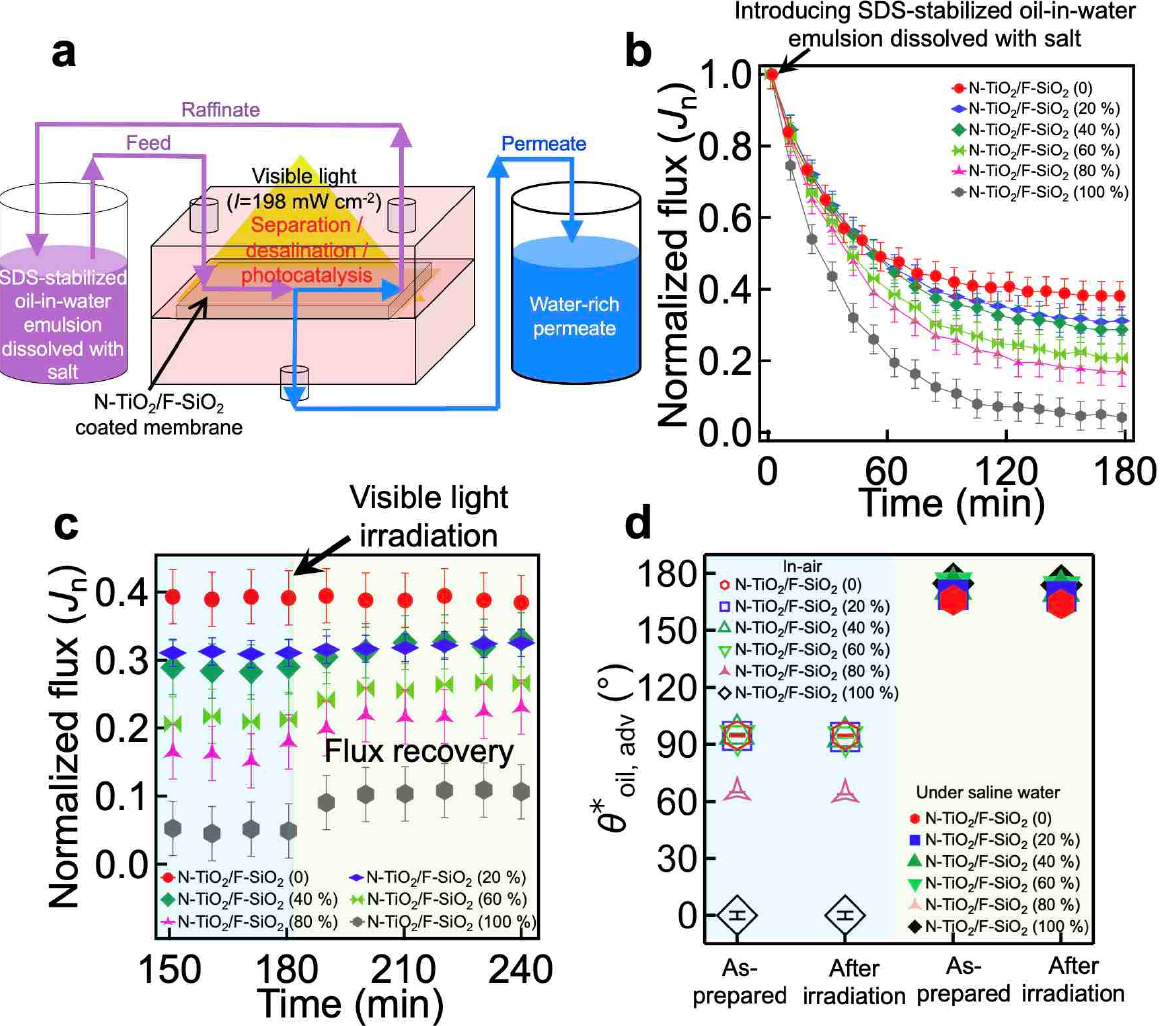
Figure 4. ( a ) Schematic illustrating the cross-flow apparatus that enables continuous separation and desalination of an oil–saline water mixture and simultaneous photocatalytic degradation of the organic foulants adsorbed onto the membrane’s surface upon visible light irradiation. ( b ) The normalized flux ( J n ) of the water-rich permeate through the membranes coated with N-TiO 2 /F-SiO 2 with varied compositions that are subjected to sodium dodecyl sulfate (SDS)-stabilized n-hex- adecane-in-water emulsion (10:90 vol:vol, n-hexadecane:water) dissolved with salt (1.0 wt% NaCl with respect to the water mass). ( c ) The normalized flux ( J n ) of the water-rich permeate through the membranes being irradiated by visible light ( I ≈ 198 mW cm − 2 ). ( d ) The apparent contact angles for oil (n-hexadecane) droplets on the membranes in air and under saline water before and after visible light irradiation for 120 min. The data of the as-prepared membranes are also shown for comparison.